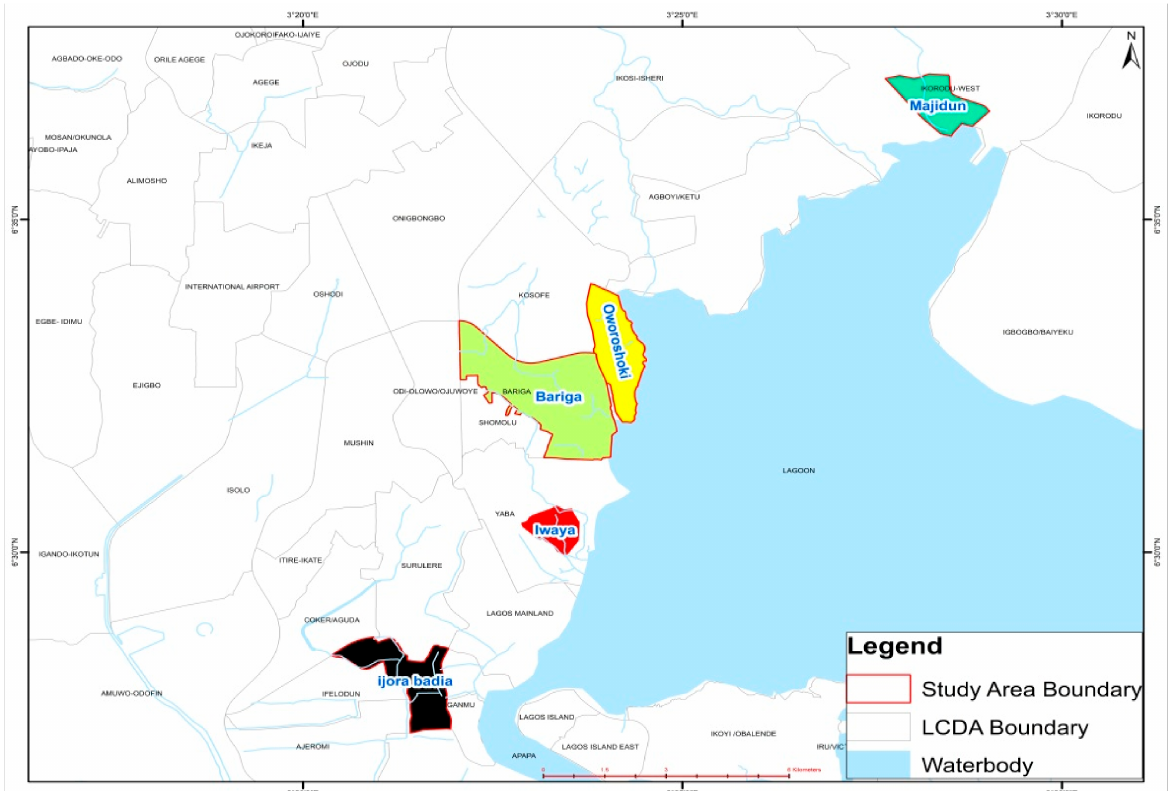
Figure 1. Map of Lagos metropolis, showing the five selected slum settlements where the study area is located, and the sample